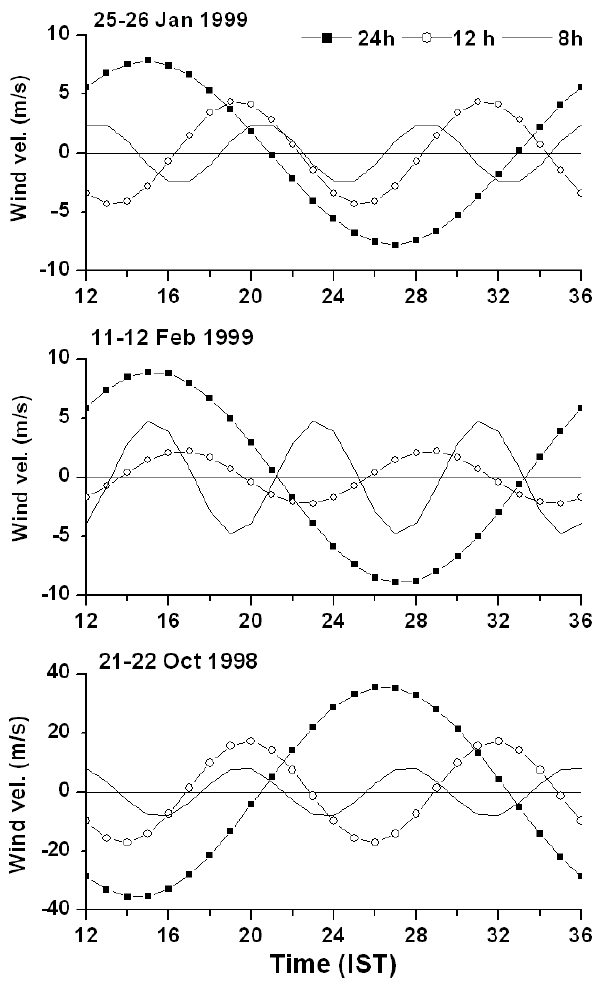
Fig. 5. Time variation of tidal components at 86km on 25–26 Jan- uary 1999 (top panel), 11–12 February 1999 (middle panel) and 21–22 October 1998 (bottom